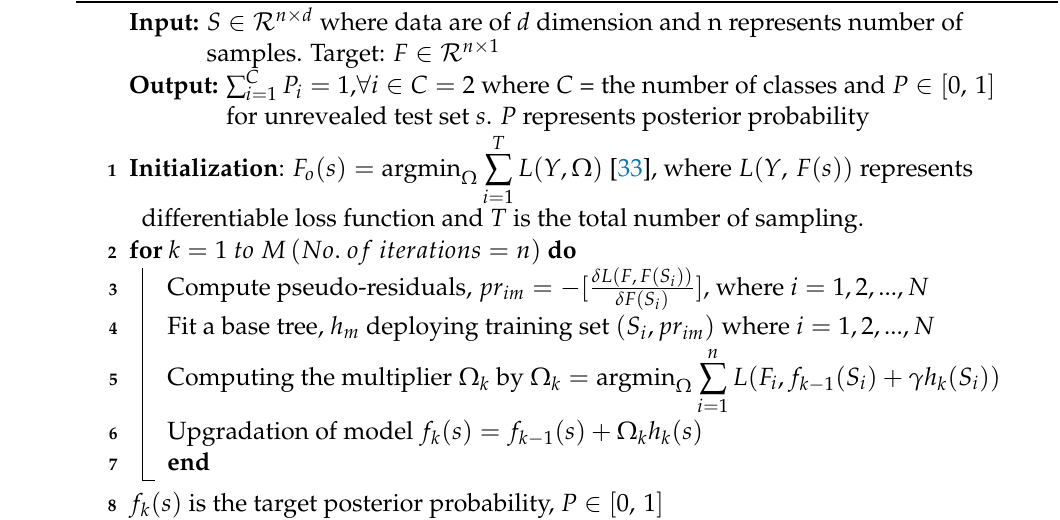
Algorithm 2: Followed steps for XGBoost classifier